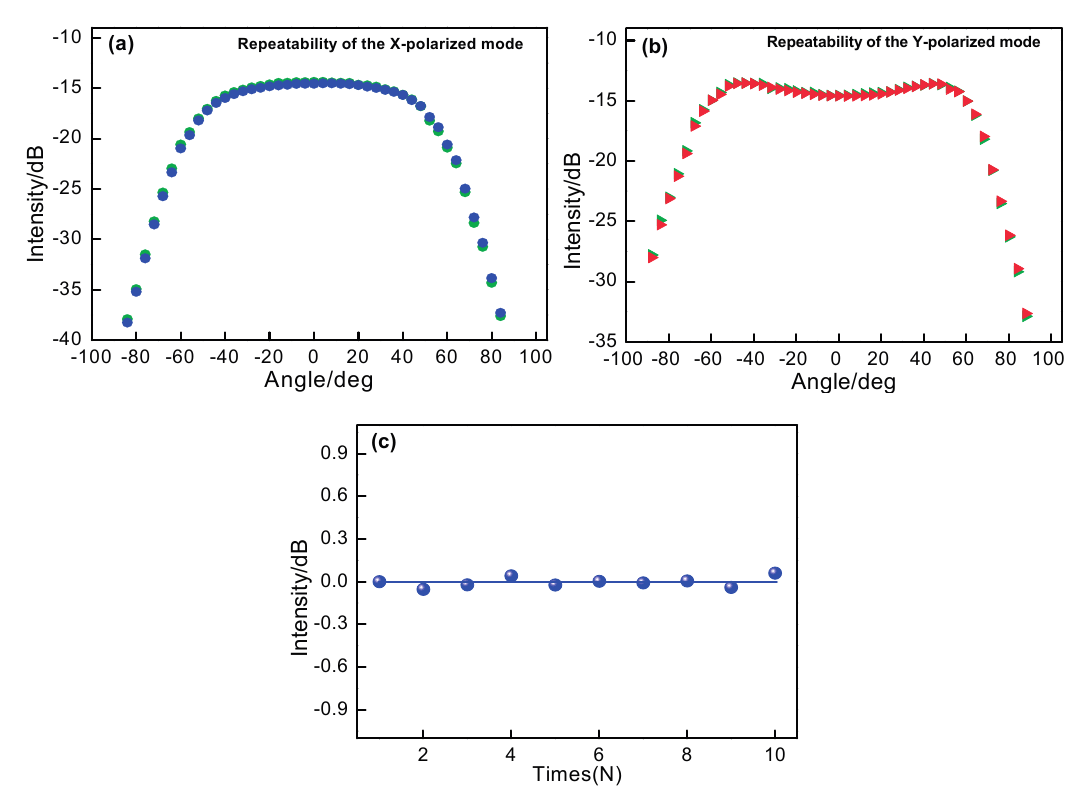
Figure 4. Repeatedly testing of the intensity responses to angles of ( a ) x -polarized mode; ( b ) y -polarized mode; and ( c ) quantitative repeatability statement at the same bending angle.